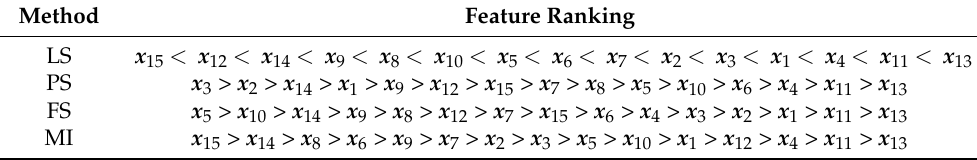
Table 5. Feature rankings under different